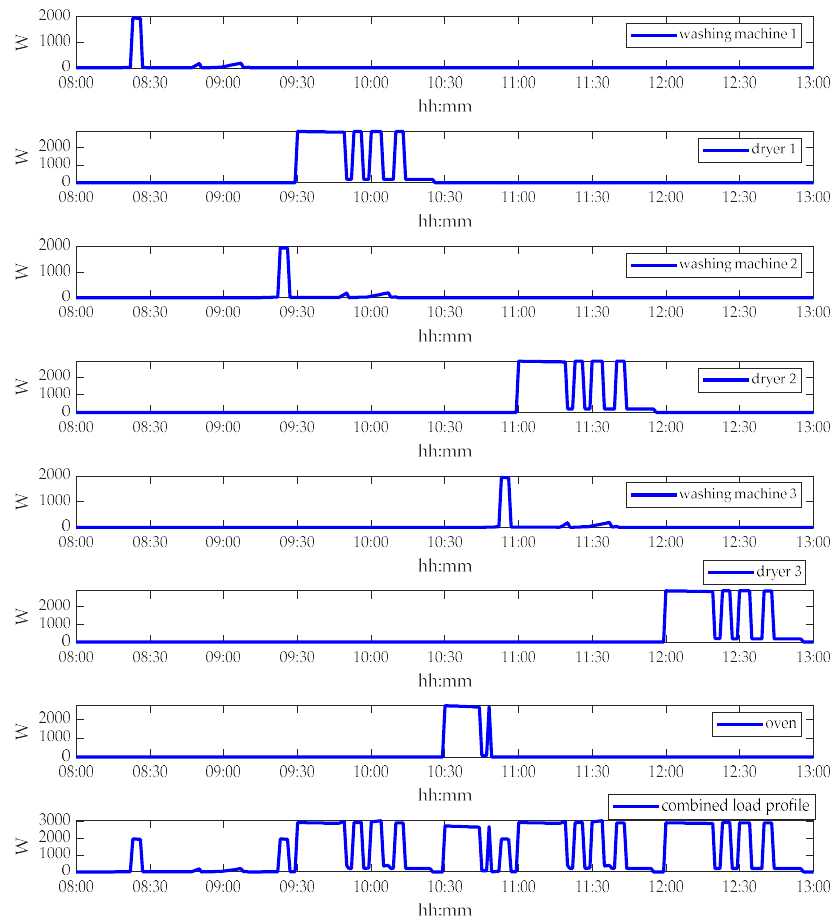
Figure 29. Simulation results in the presence of a perturbation.